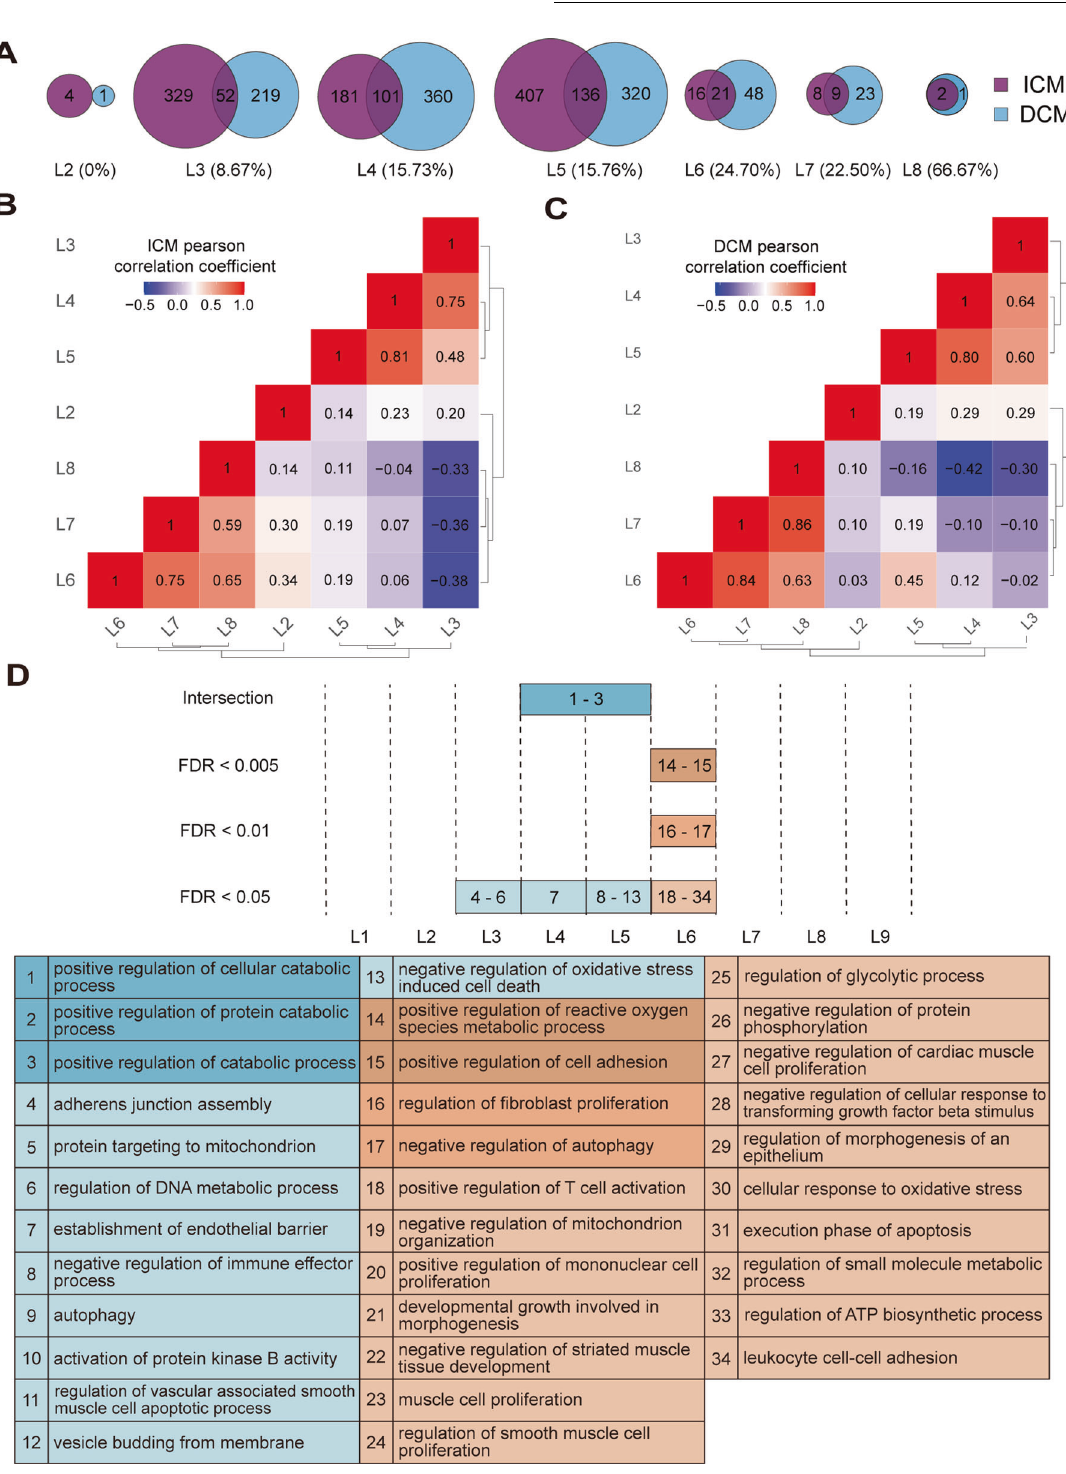
Fig. 3 Comparison and analysis of ICM and DCM progression. A The number and the proportion of common dysregulated LMM-CTs at each time ordered level for ICM and DCM. The number in parentheses denotes the proportion of common dysregulated LMM-CTs at that level. B , C The hierarchical clustering of the PCC among different time-ordered levels for ICM and DCM, respectively. D The overrepresented functions using mRNAs in DCM dysregulated LMM-CTs at each time-ordered level. The numbers in the plot (Top) correspond to the index number of signi fi cantly enriched functions listed in the table (Bottom). The blue and orange colors represent DCM at the progressed and advanced stage, distinguishing ICM/DCM patients from the NF controls (denoted as NF-ICM and NF-DCM), and the other was for differentiating ICM from DCM patients (denoted as ICM-DCM). two types of diagnostic biomarkers were identi fi ed. One was for